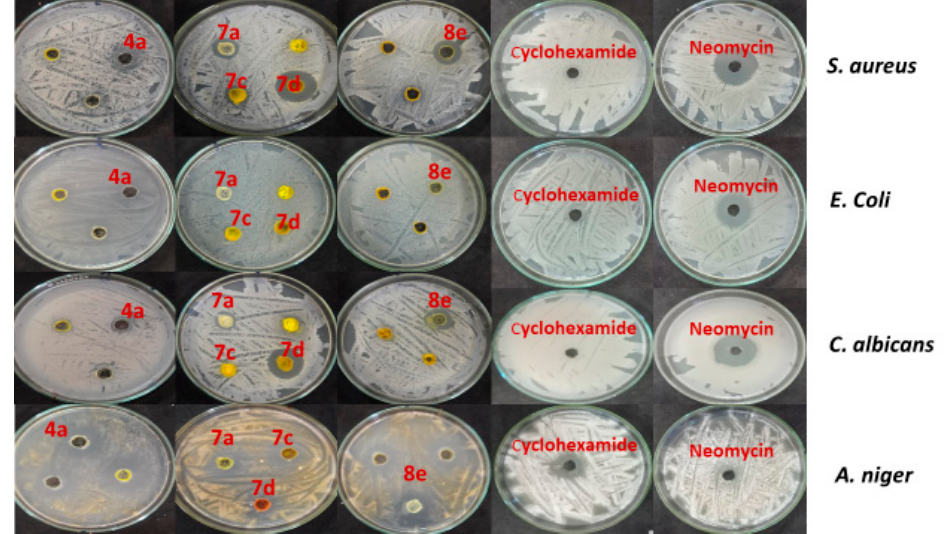
Figure 2. The inhibition zone ( ф mm) of the most active selected compounds against various pathogenic microorganisms.